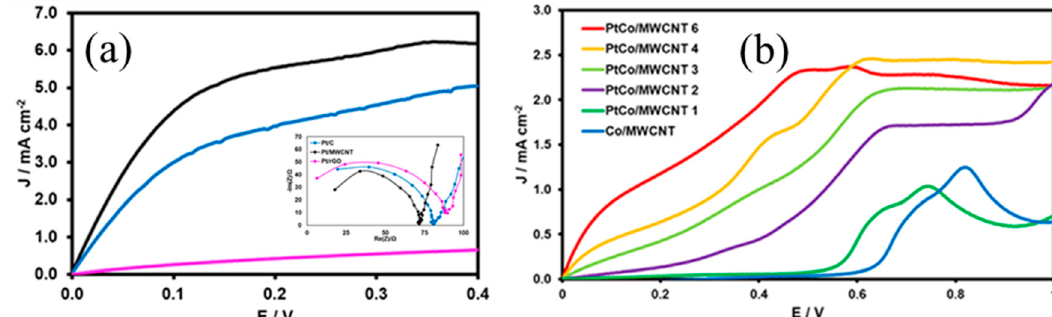
Figure 4. Linear sweep voltammograms of the ( a ) Pt catalysts on different carbonaceous supports (inset: electrochemical impedance spectra of the Pt catalysts in different supports) and ( b ) PtCo/MWCNT catalysts with different Pt loading in a solution of NaOH 0.1 M saturated in hydrogen at 1600 rpm at a scan rate of 10 mV s − 1 .